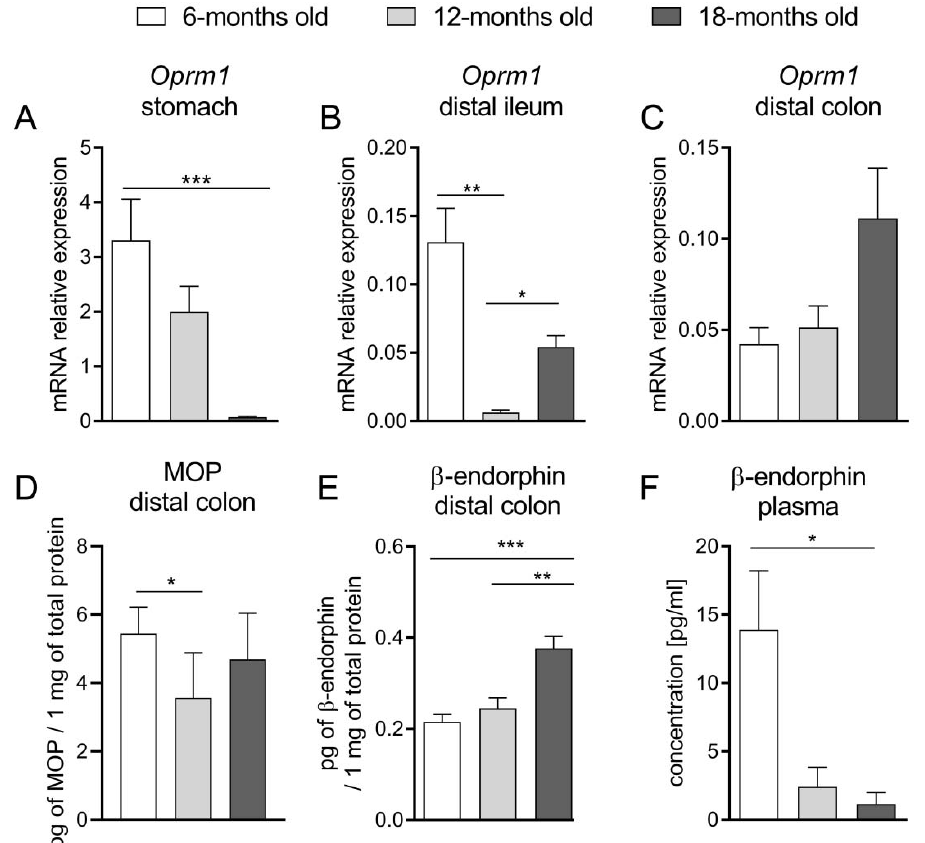
Figure 3. The mRNA expression of the Oprm1 gene, encoding MOP receptor, in the stomach ( A ), distal ileum ( B ) and distal colon ( C ). Theprotein expression of MOP receptor ( D ) and β -endorphin ( E ) in the colon, the concentration of β -endorphin in the plasma ( F ) of 6-, 12- and 18-months old mice. Welch ANOVA test followed by Tamahane’s T2 multiple comparison test was used to evaluate the difference between groups ( A – C ). One-way ANOVA followed by Bonferroni correction test was utilized for multiple comparison in case of block ( C , D ). * p < 0.05, ** p < 0.01, *** p < 0.001.